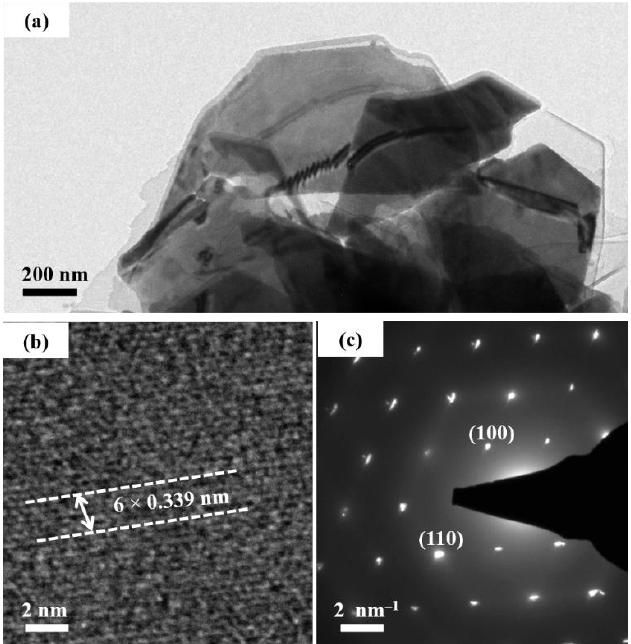
Figure 4. ( a ) Low-resolution TEM micrograph of PbI 2 platelets; ( b ) high-resolution TEM micrograph of the platelet in ( a ) showing atomic planes of PbI 2 ; ( c ) selected area electron diffraction pattern of the PbI 2 platelet showing a single-crystalline nature.